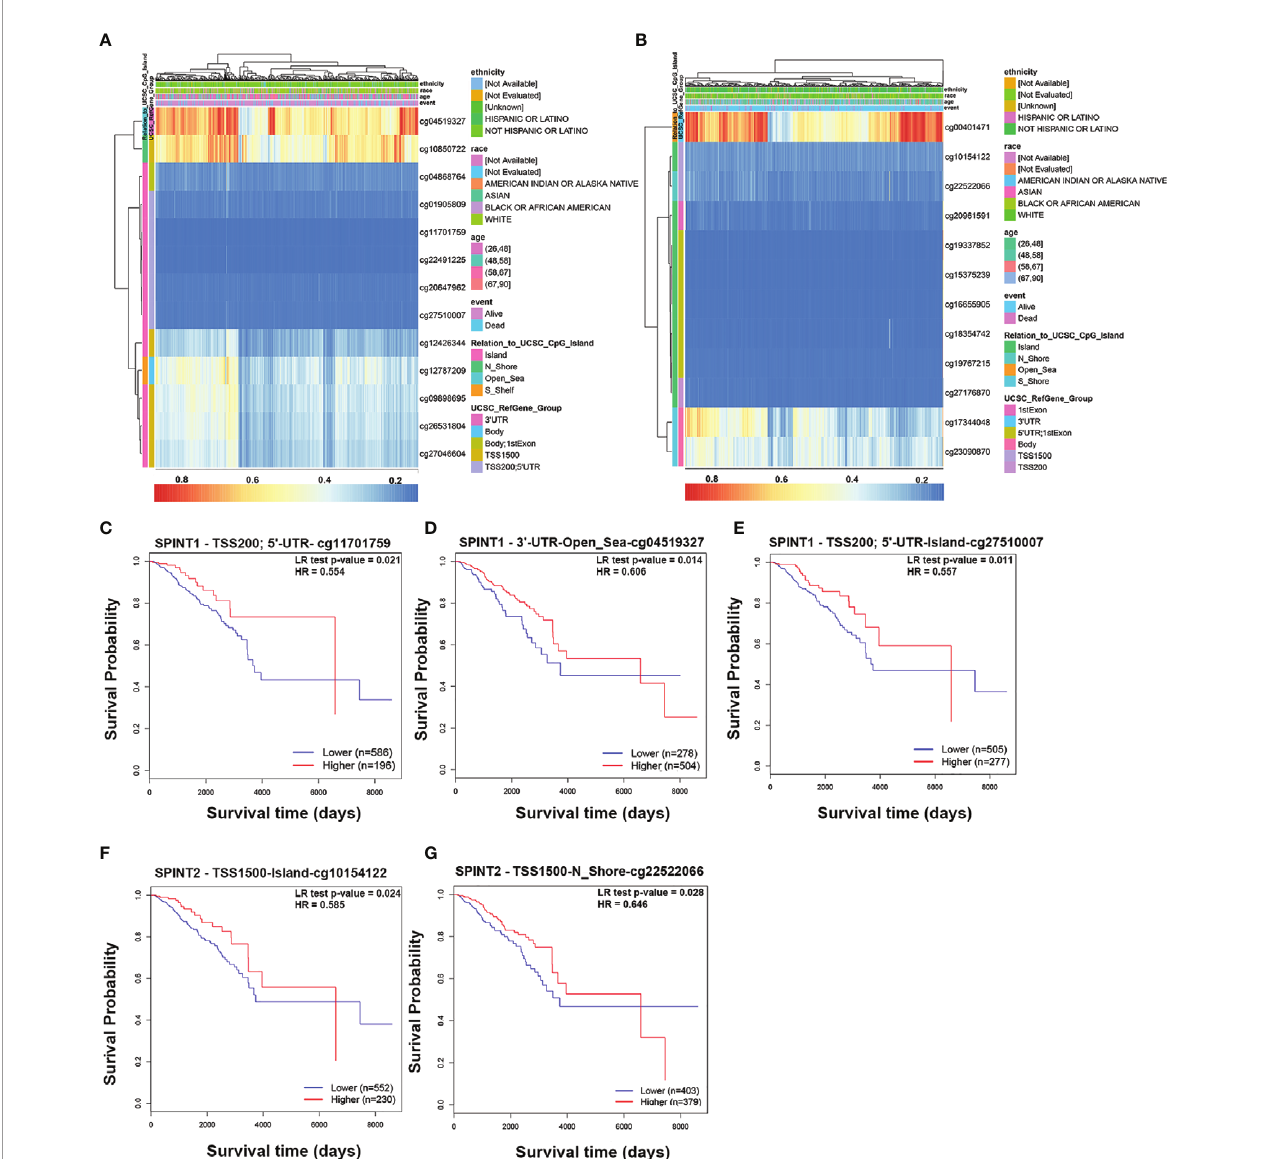
FIGURE 6 | Methylation of SPINT1/2 was correlated with prognosis in breast cancer from MethSurv. Heatmaps of the association between methylation level of SPINT1 (A) and SPINT2 (B) and patient characteristics and genomic subregions. Association of methylation at TSS200; 5 ’ UTR-cg11701759 (C) , 3 ’ UTR-Open_Sea- cg04519327 (D) and TSS200; 5 ’ UTR-Island-cg27510007 (E) in SPINT1 with patient OS. Correlation between methylation at TSS1500-Island-cg10154122 (F) and TSS1500-N_Shore-cg22522066 (G) in SPINT2 and